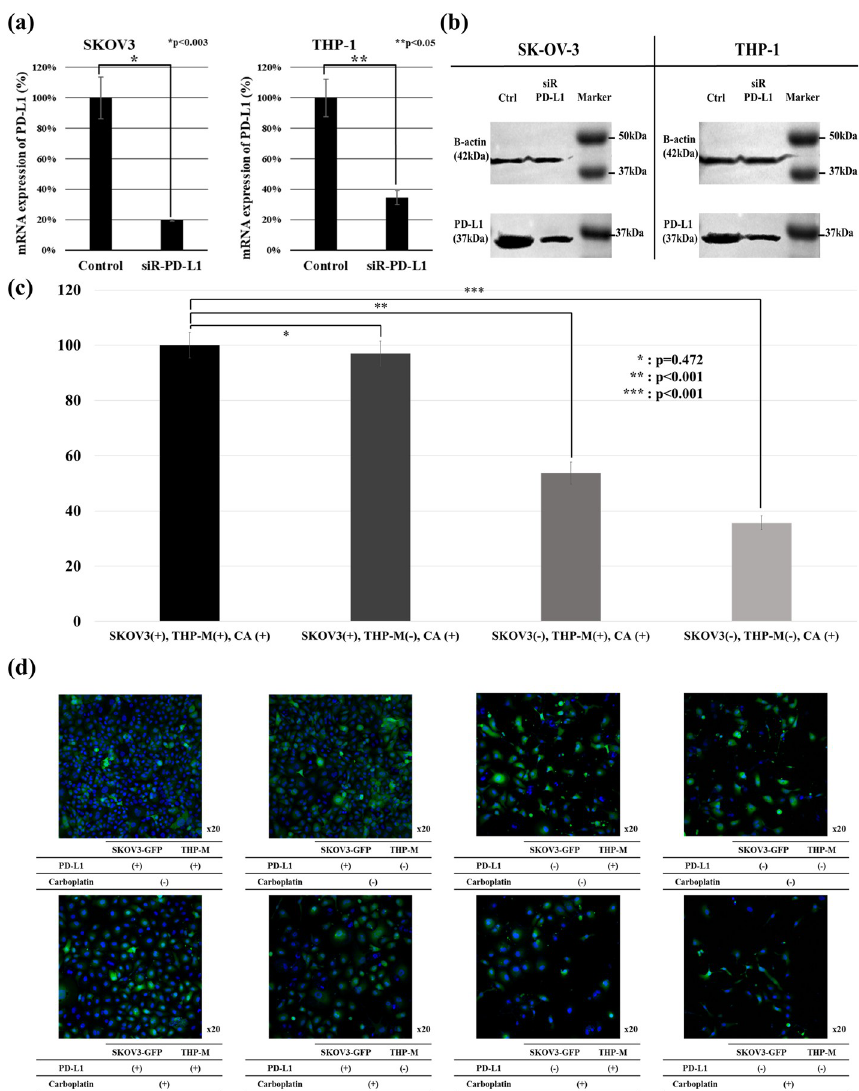
Fig 4. Silencing of PD-L1 in human ovarian cancer and macrophage cell lines. (a) Silencing of PD-L1 in SKOV3 and THP-1 cells. � p = 0.472, �� p < 0.001, ��� p < 0.001. (b) Western blotting shows reduced PD-L1 protein expression. (c) Viability of PD-L1 -silenced SKOV3 and THP-1 cells after carboplatin treatment. (d) Confocal fluorescence microscopic images of SKOV3 cells. The proteins PD-1 (encoded by PDCD1 ) and PD-L1 (encoded by CD274 ) are crucial factors for immune homeostasis [23]. However, the PD-1/PD-L1 axis in the TME is deregulated by cancer cells and TAMs to escape immune surveillance [24]. Therefore, PD-L1-expressing TAMs contribute to an immunosuppressive TME. We identified the robust expression of PD-L1 in both the tumor cells and TAMs following co-culture. Remarkably, our Transwell co- culture assay revealed that ovarian cancer cells became resistant to carboplatin after co-cultiva- tion with macrophages. Although the role of the PD-L1 and PD-1 interaction in regulating T- cell suppression has been well established, little is known about PD-L1 signaling in ovarian cancer chemotherapy resistance. Thus, we hypothesized that PD-L1 in both ovarian cancer cells and TAMs might be associated with carboplatin resistance. In our experiments, PD-L1